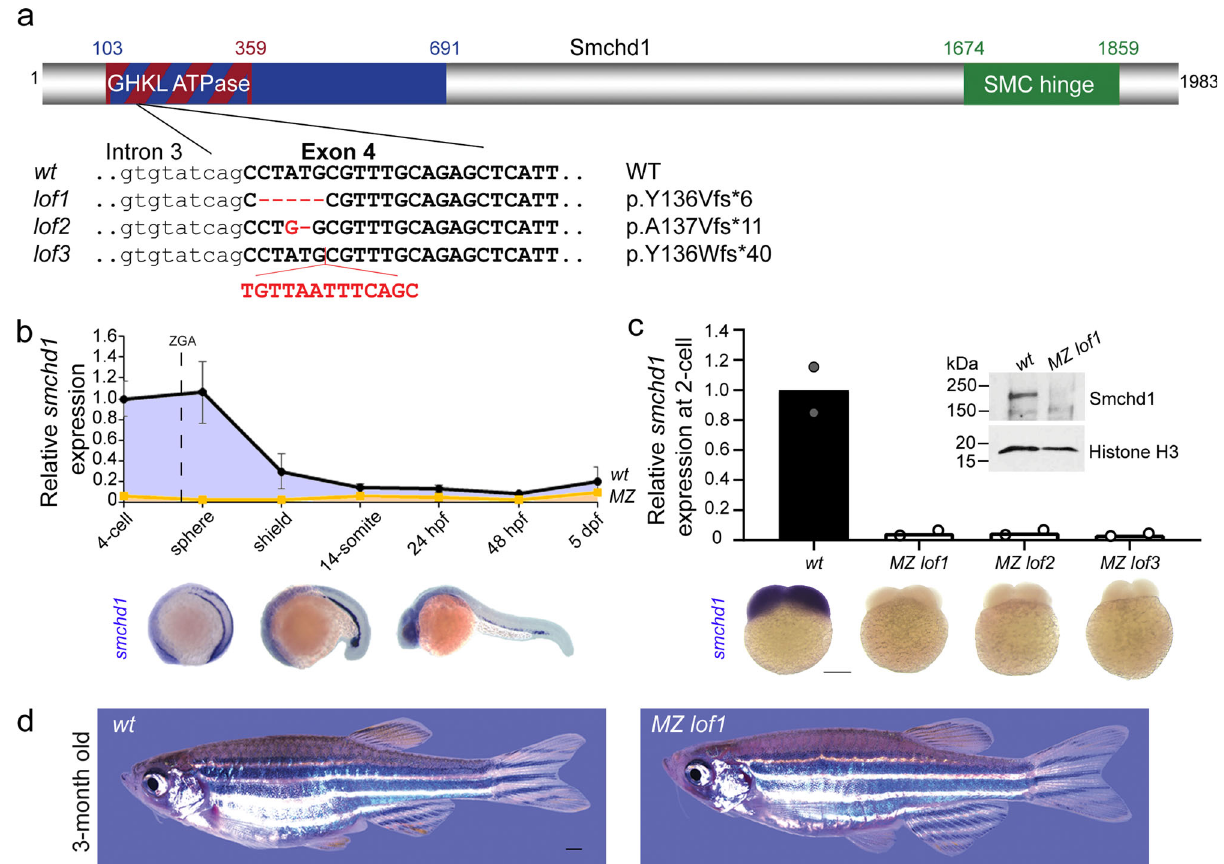
Fig. 1 Generation of MZ smchd1 null zebra fi sh. a Three loss-of-function (LoF) alleles in zebra fi sh were generated by CRISPR/Cas9 injections targeting smchd1 . b Endogenous spatial-temporal expression pattern of smchd1 in zebra fi sh embryos as determined by qPCR and WISH. n = 3 biological samples (qPCR), 3 independent experiments with at least 20 embryos each (WISH). Data are presented as mean values ± SD. c Maternal zygotic (MZ) smchd1 lof embryos lack smchd1 mRNA (qPCR and WISH) and protein (Western blot), suggestive of total nonsense-mediated decay. Scale bar = 200 μ m. n = 2 biological samples (qPCR, Western blot), 3 independent experiments with at least 20 embryos each (WISH). d MZ smchd1 lof zebra fi sh are viable and fertile, and do not model arhinia at 3 months. Scale bar = 1